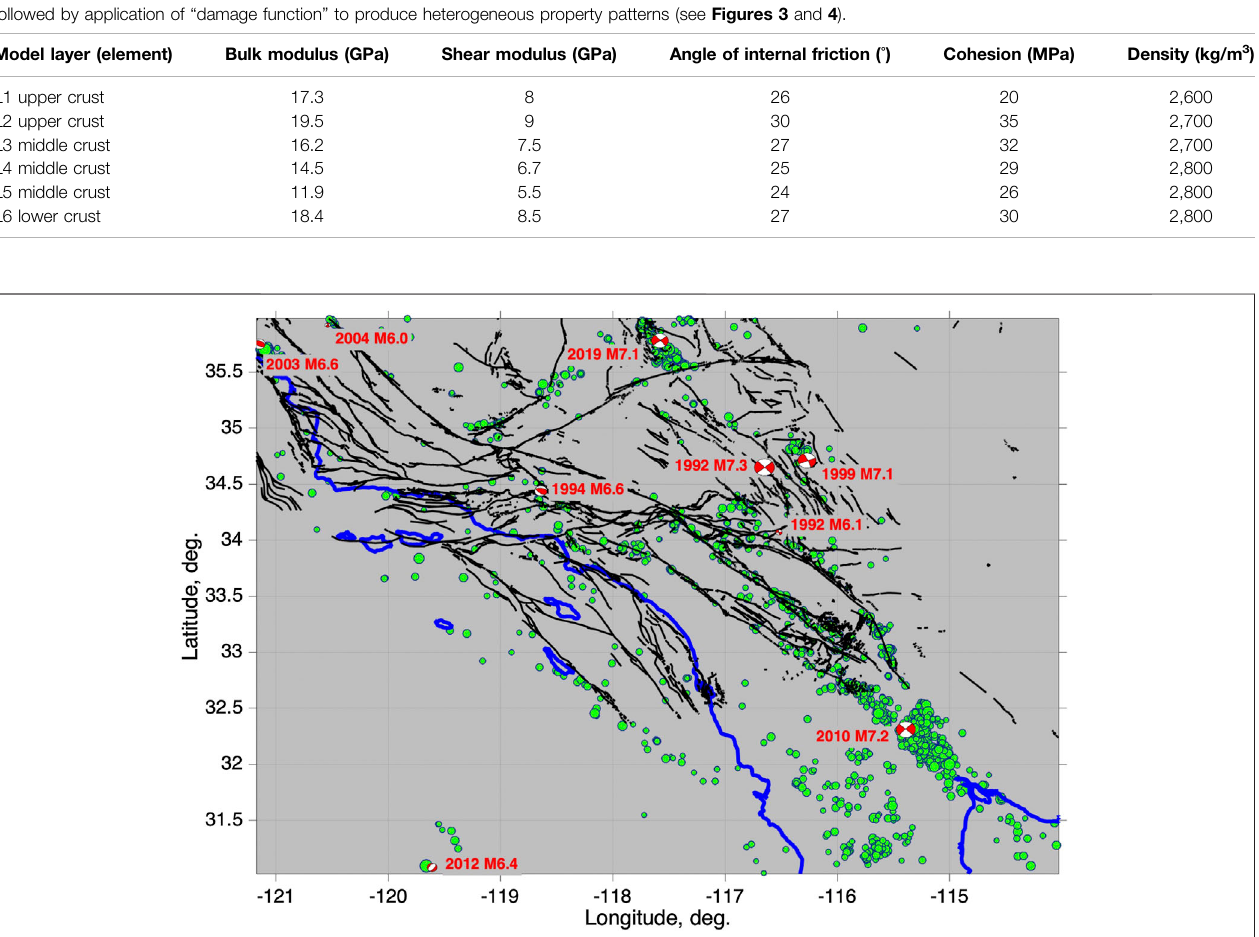
Frontiers in Earth Science |